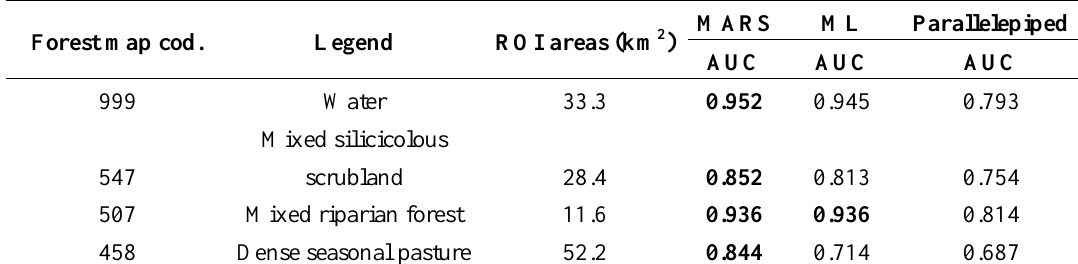
Table 4 . Area under the ROC curve (AUC)